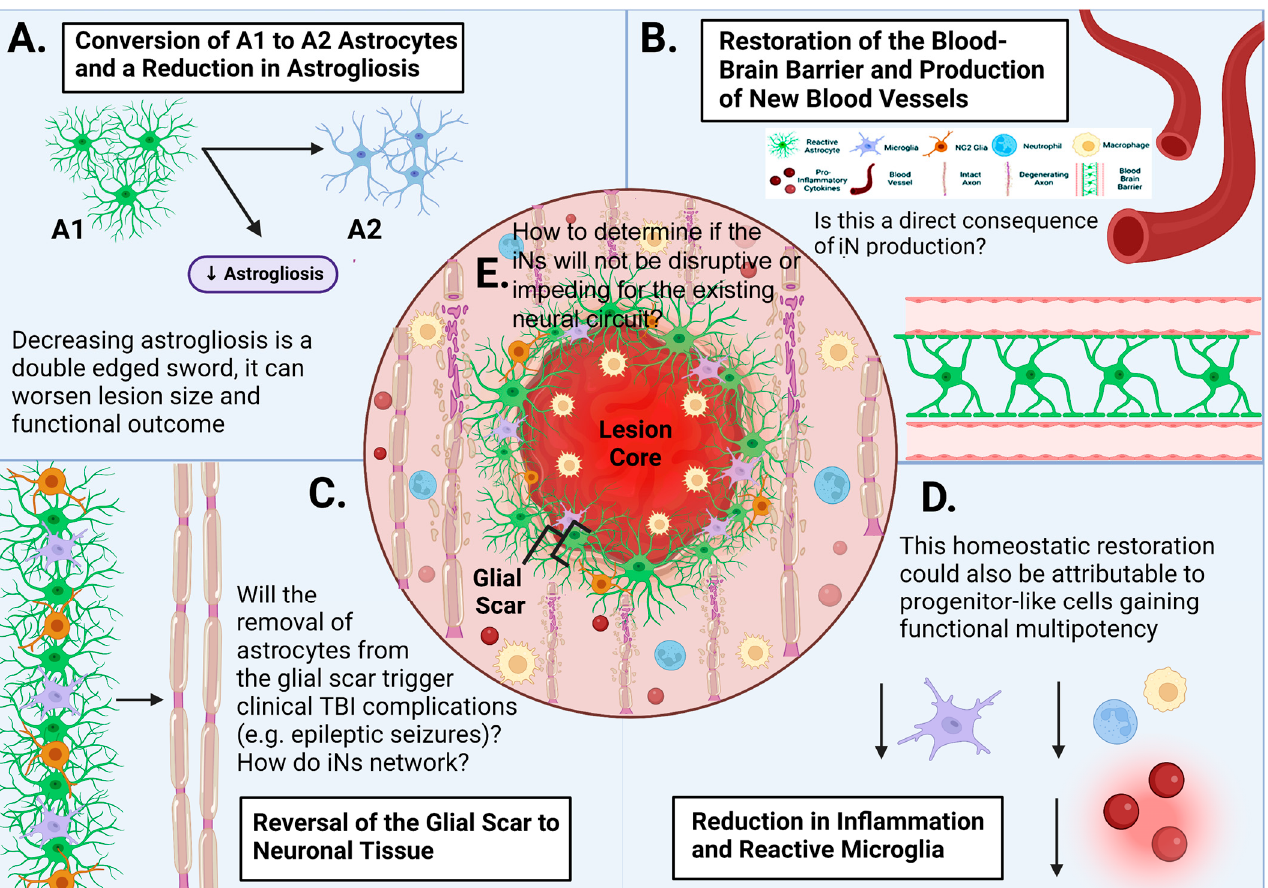
Figure 3. Other therapeutic effects proposed to occur as a result of treatment with AtN